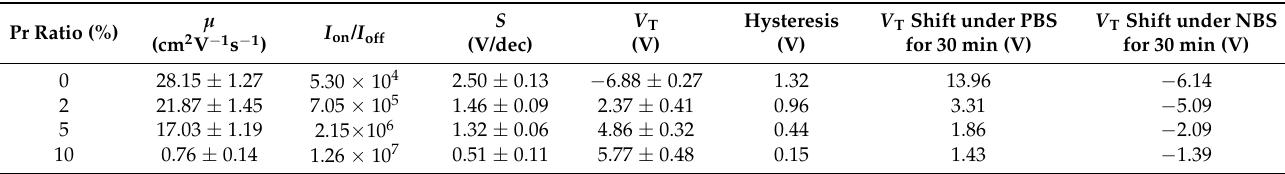
Table 1. Electrical characteristics of In-Pr-O